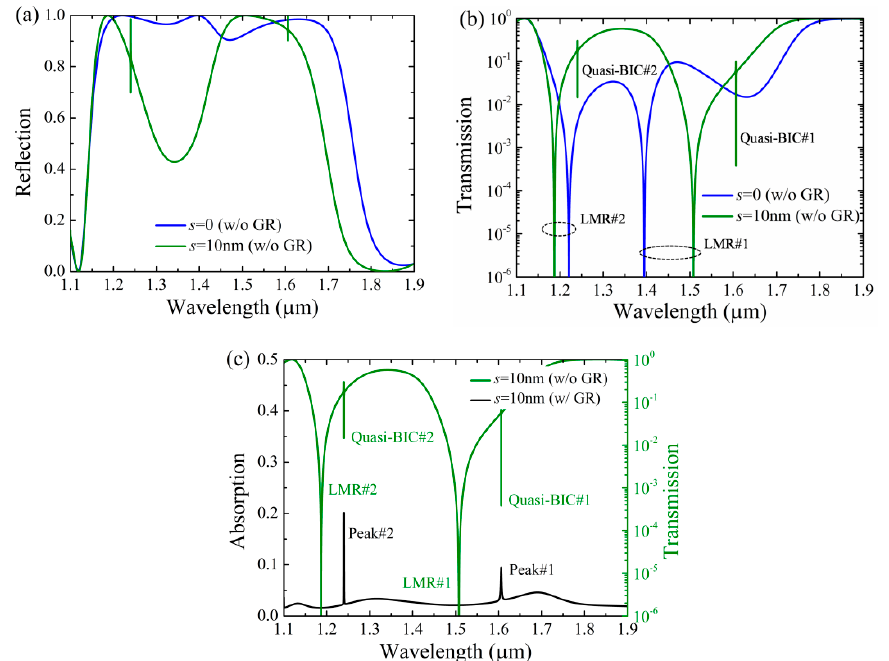
Figure 3. Spectral responses of the Si-based PCS without graphene (w/o GR) and with graphene (w/ GR). Other parameters are the same as those in Figure 2. ( a ) Reflection responses with s = 0 and s = 10 nm. ( b ) Transmission responses with s = 0 and s = 10 nm. ( c ) Absorption and transmission responses with s = 10 nm.